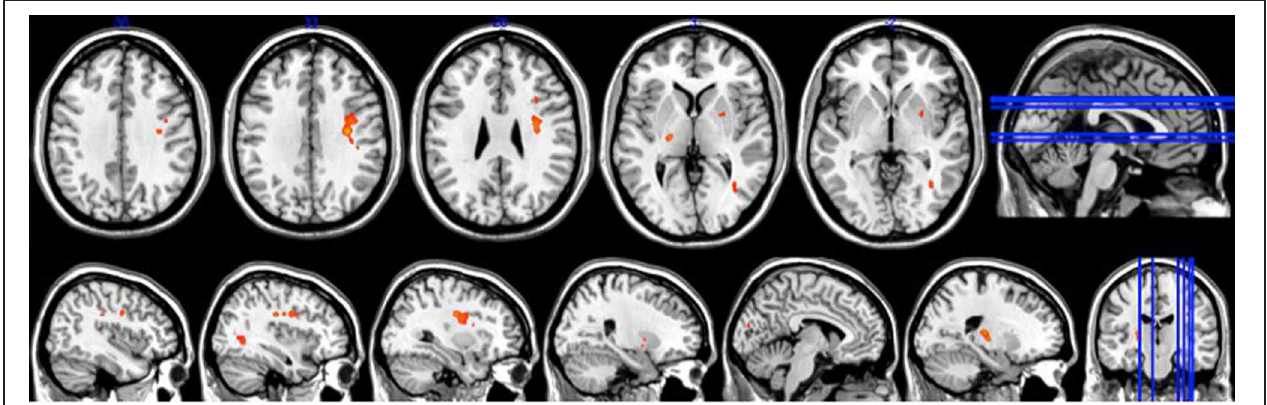
FIGURE 5 | Brain activation associated with temporal precision at retention ( p < 0 .